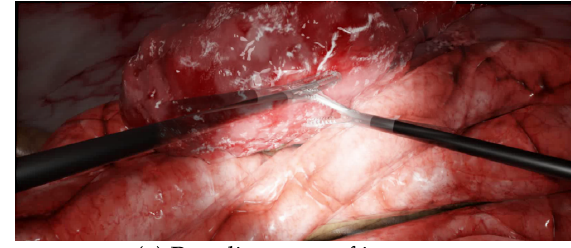
( a ) Pre-alignment of images Figure 3c,d using global homography.